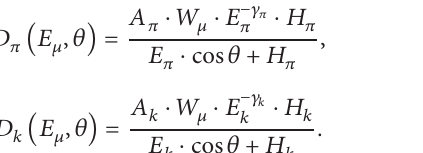
Figure 4: The detection